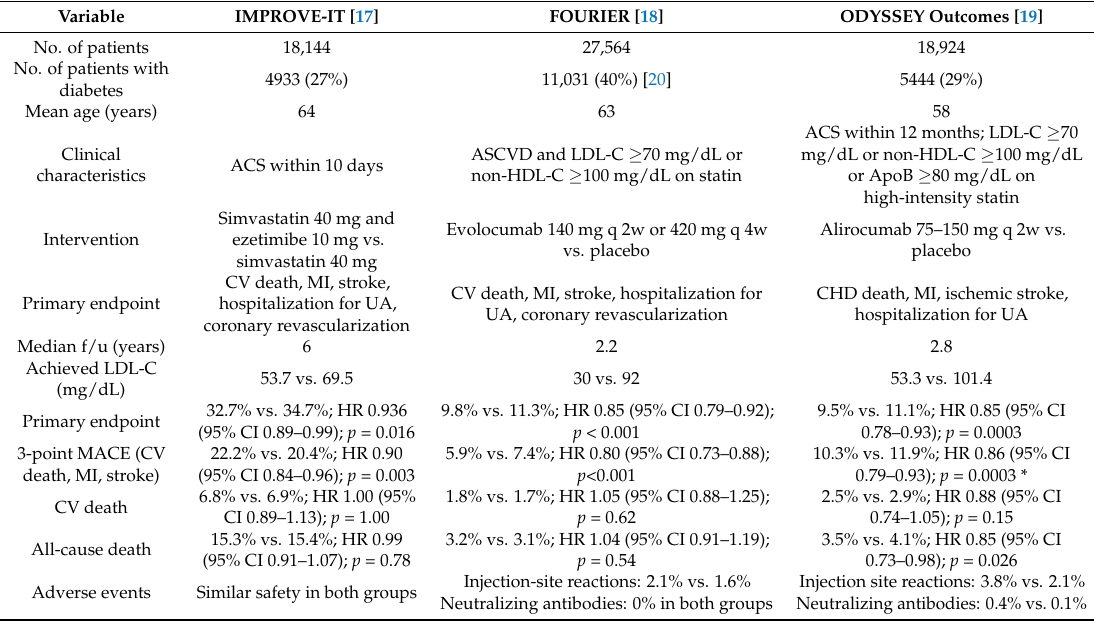
Table 1. Cardiovascular outcome trials of nonstatin